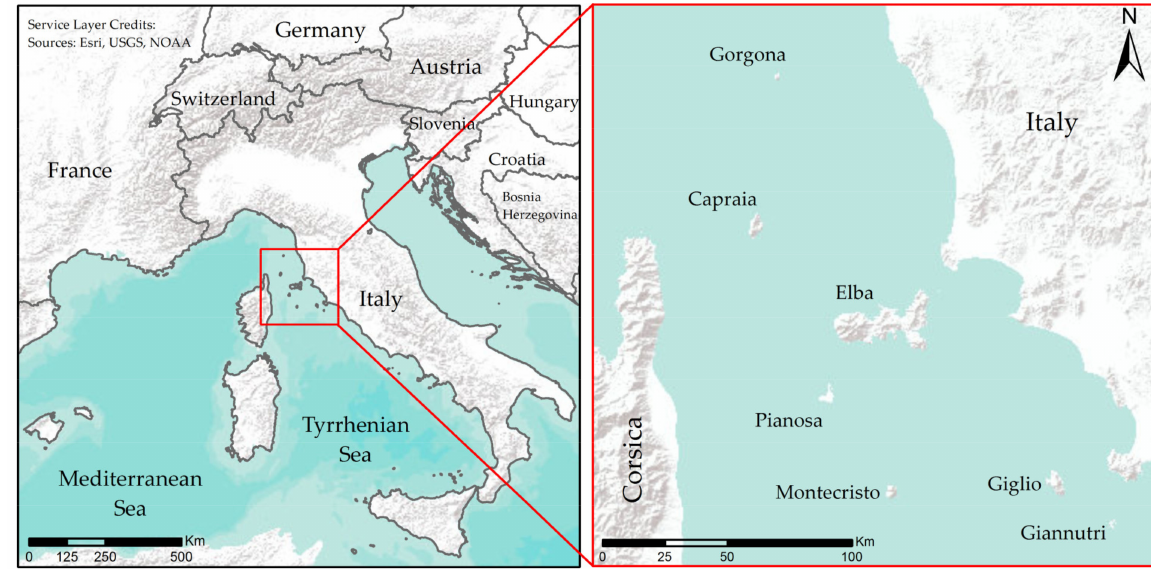
Figure 1. Study area. The seven main island of the Tuscan Archipelago (Gorgona, Capraia, Elba, Pianosa Montecristo and Giannutri) in the Tyrrhenian Sea, located between the Tuscany coast (Italy) and Corsica